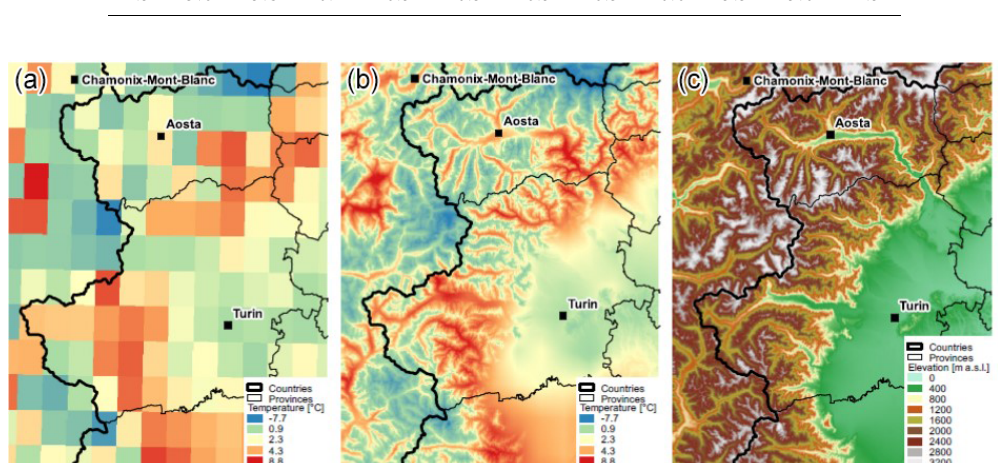
Figure 2. Maximum temperature field at (a) 0.125 ◦ longitude–latitude spatial resolution from the original OI dataset and at (b) 250m resolution after interpolation with orographic correction, for 1 January 2009. Panel (c) shows the orography of the study area from a digital elevation model derived from the SRTM project, interpolated at 250m of spatial resolution.